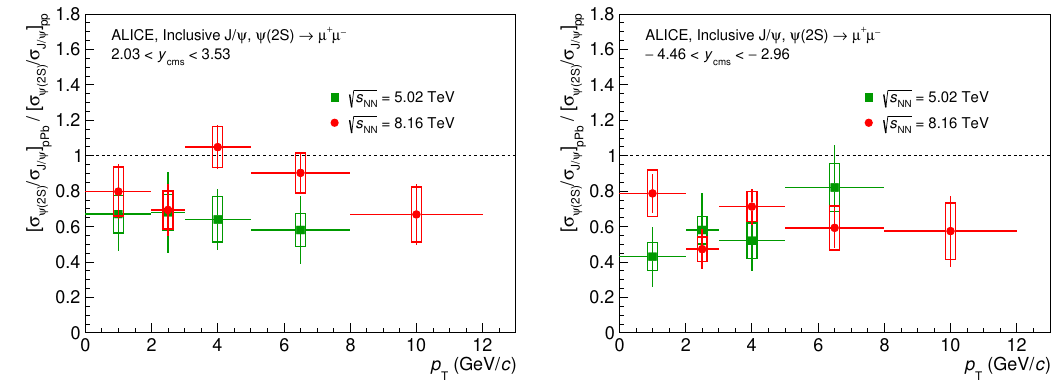
Figure 11 . Double ratio of (2S) and J/ cross sections in p-Pb and pp collisions as a function p of transverse momentum, at forward (left) and backward (right) rapidity at s NN = 8 : 16 TeV, p compared with the corresponding results at s NN = 5 : 02 TeV [31]. The error bars represent the statistical uncertainties, while the boxes correspond to uncorrelated systematic